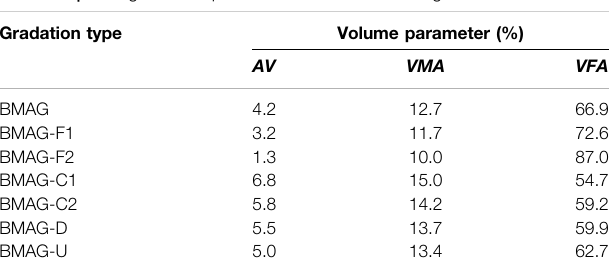
TABLE 4 | Average volume parameters of HMA for each